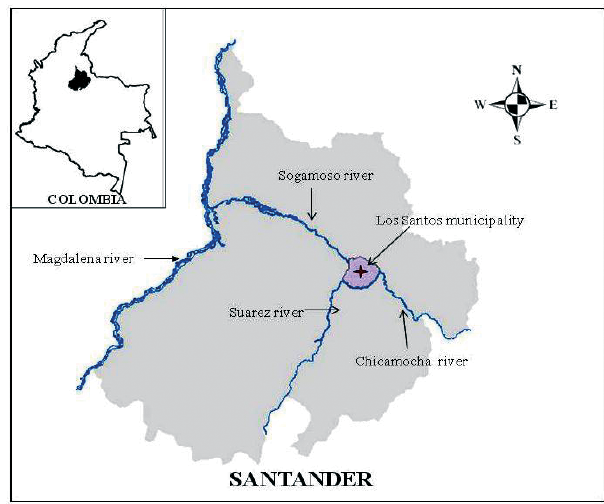
Fig. 1. Map of Santander Departament in northeastern Co- lombia with the approximate location of the collecting site of Trichomycterus uisae , in Cueva El Misterio, upper Sogamoso River basin.